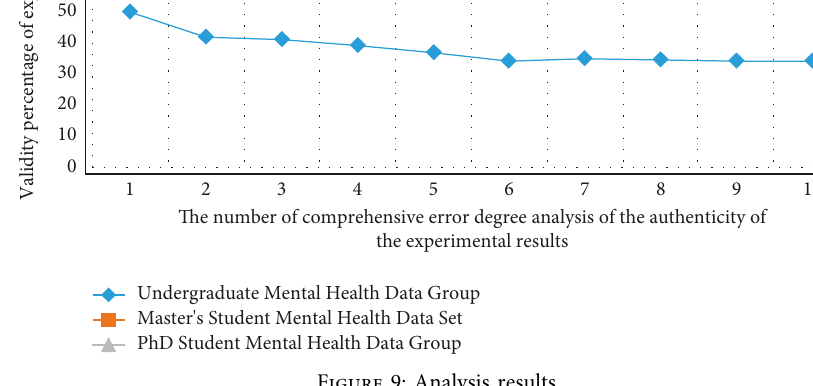
Figure 9: Analysis